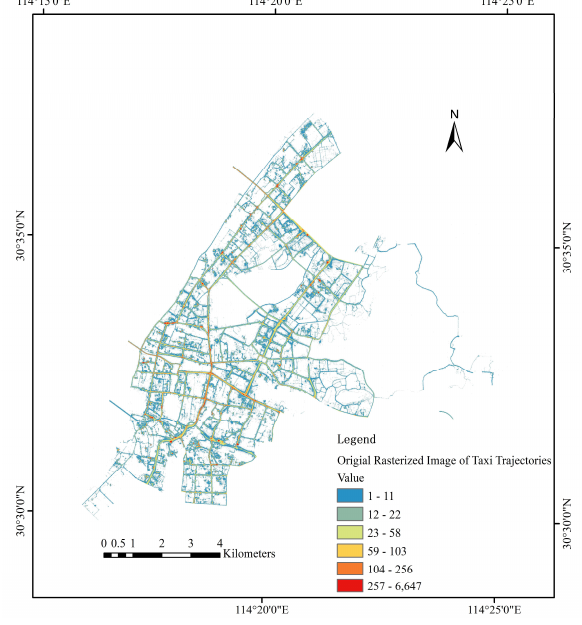
Figure 4. Six-class classification rasterized image of taxi trajectories (Zhang, 2020).